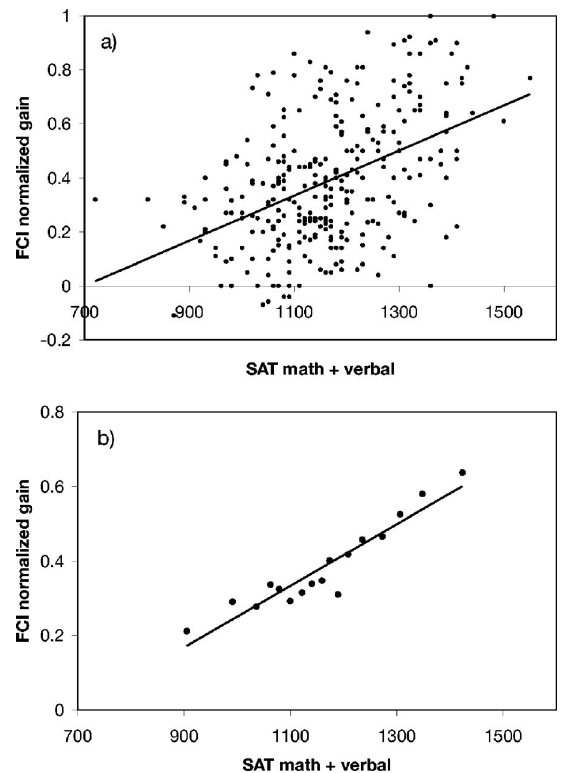
FIG. 1. (cid:1) a (cid:2) Plot of individual students’ normalized FCI gains versus SAT scores for 292 LMU students: slope=0.00084, r =0.46. (cid:1) b (cid:2) Plot of normalized FCI gains versus SAT scores, with individual student data averaged within 17